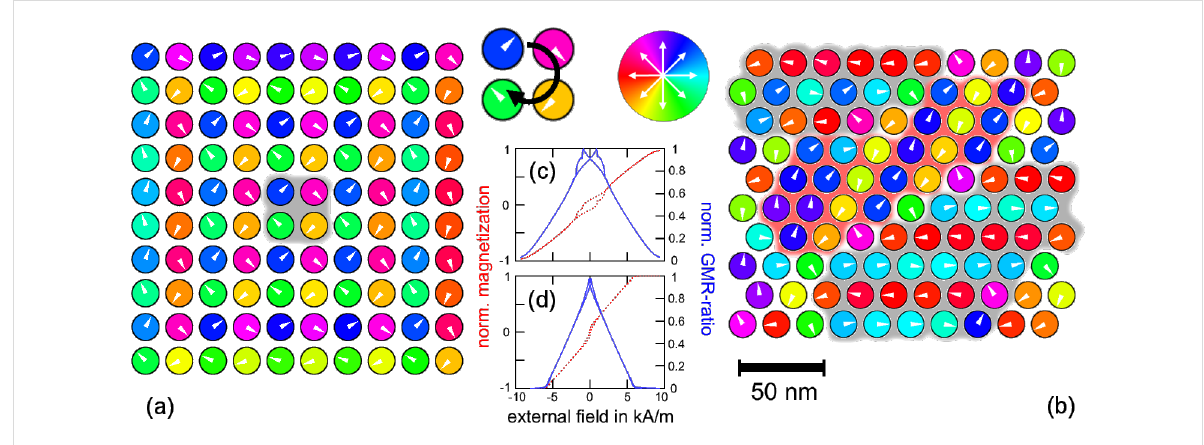
Figure 17: Equilibrium states of 10 × 10-particle arrays with cubic and hexagonal symmetry. Magnetic moments in cubic particle assemblies align in vortex-like 2 × 2-states while hexagonal symmetries entail domains of antiparallel ordering. The stability of the vortex states against external perturba- tions result in a hysteretic magnetization/GMR behavior, while hexagonal arrays have a linear behavior.